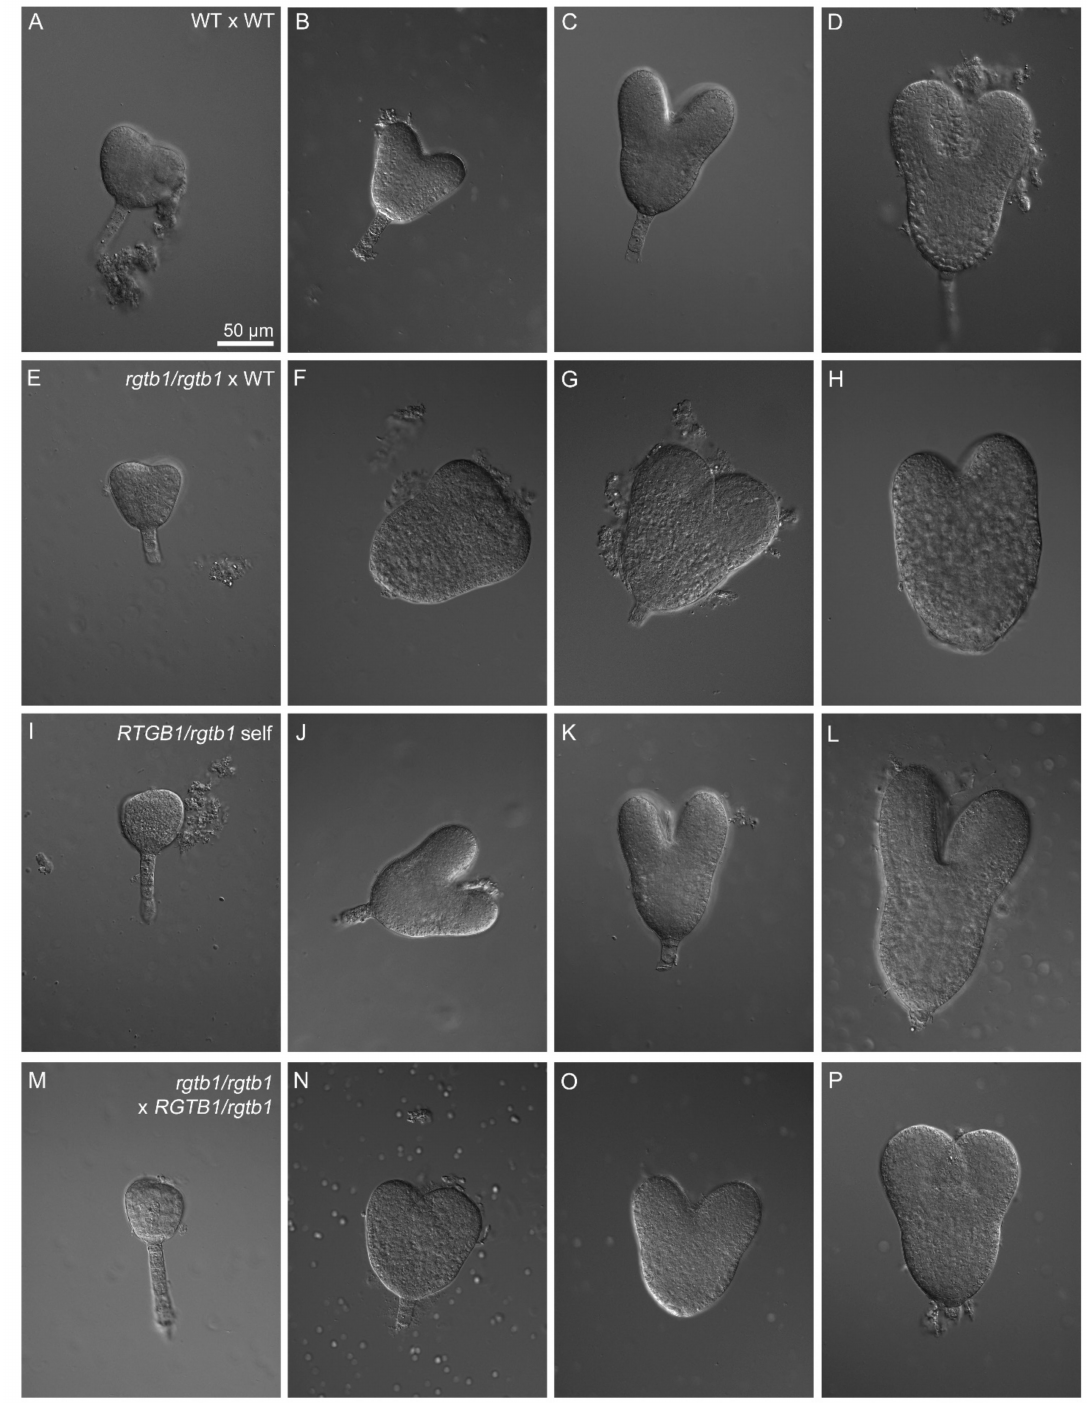
Figure 6. Deformed embryos form on the rgtb1 mother plant regardless of the pollen donor. Morphology of the embryos from the early heart stage until the torpedo stage formed on WT or rgtb1 mother plants; microscopy images in DIC contrast. ( A – D ) Embryos formed on the WT plant after self-pollination, ( E – H ) embryos formed on the rgtb1 plant after pollination with WT pollen, ( I – L ) embryos formed on the RGTB1 / rgtb1 plant after self-pollination and ( M – P ) embryos formed on the rgtb1 plant after pollination with pollen coming from RGTB1 / rgtb1 plant. Note the characteristic widening in the middle part of the embryo and cotyledon shortening in images ( F – H ) and ( N – P ); no changes were seen in the suspensor and hypophysis formation in all images. The scale bar of 50 µ m in ( A ) is the same in all